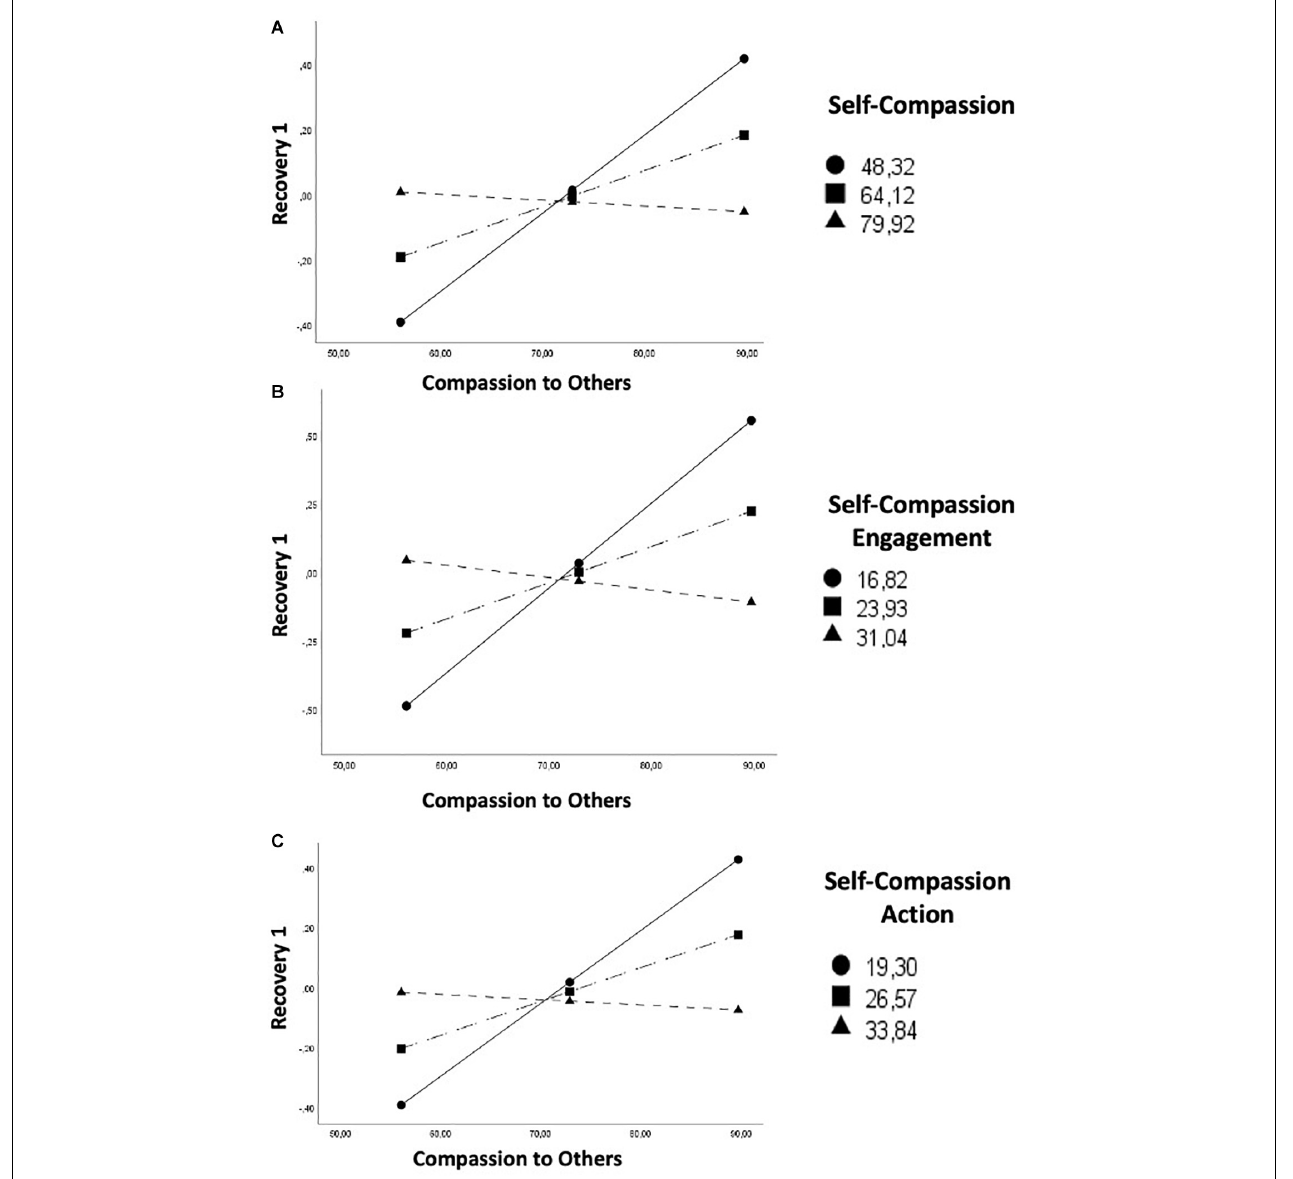
FIGURE 3 | Self-compassion [total score, (A) ; Engagement subscale, (B) ; and Action subscale, (C) ] moderates the association between Compassion for Others and High-Frequency Heart Rate Variability (HF-HRV) recovery from Video